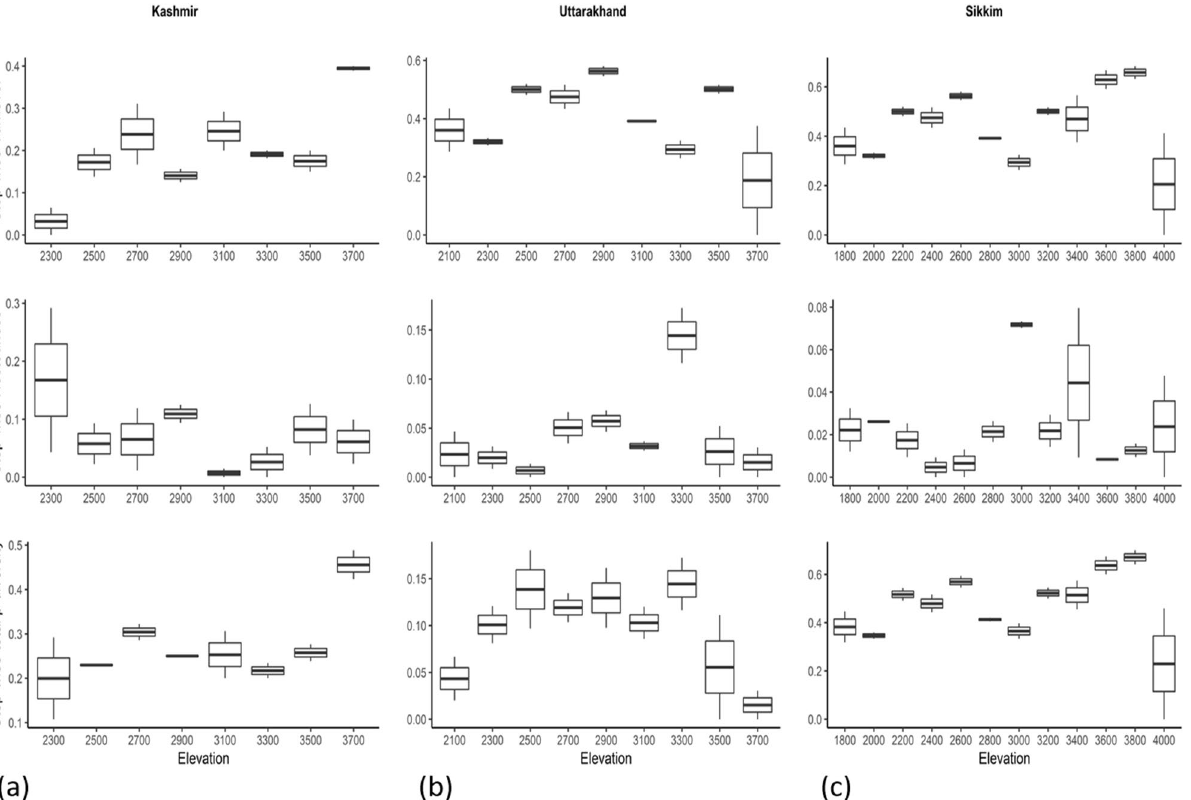
Figure 11. Stepwise turnover, nestedness and total β-diversity (pair-wise comparisons) of adjacent elevations in (a) Kashmir, (b) Uttarakhand and (c) Sikkim (the elevation band represents its comparison with adjacent elevation bands below and above